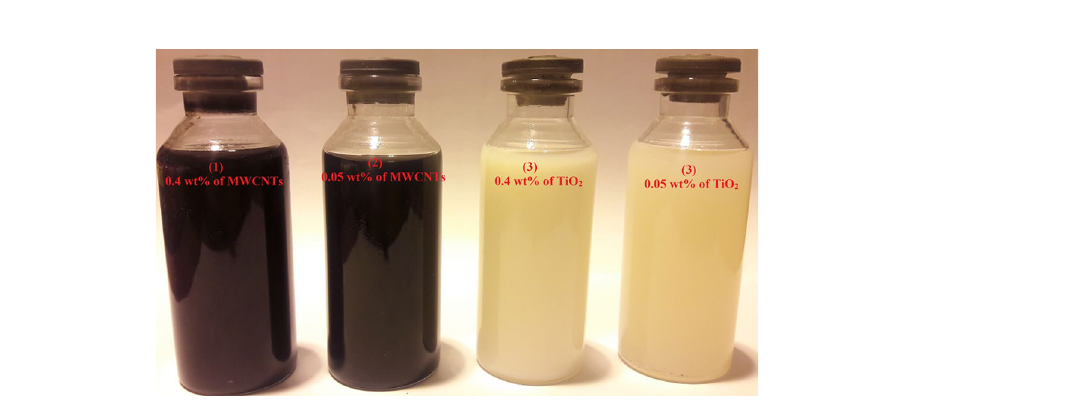
Figure 7. DLS images of the MWCNTs nanoparticles 41 .